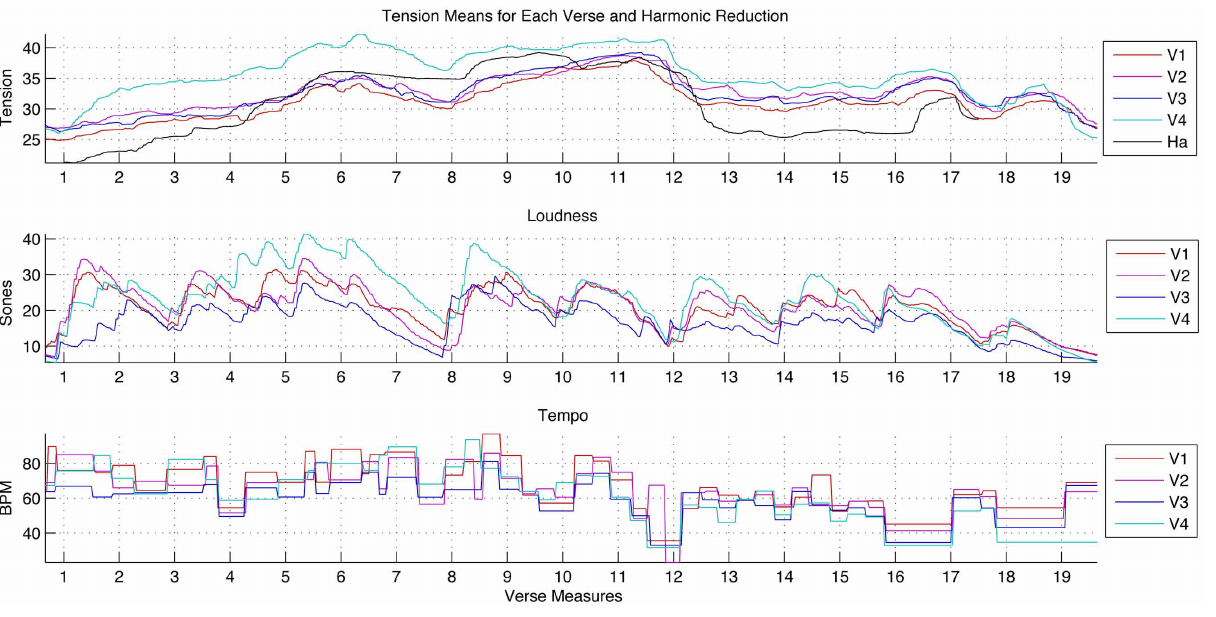
onset-determinedlocaltempo,alsoalignedtotheversemeasures,forthe performed verses. These last two feature graphs do not include the harmonic reduction, since tempo and loudness were constant across all